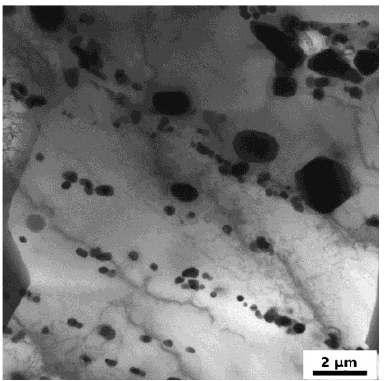
Figure 6. Transmission Electron Microscopy (TEM) micrograph of F0 specimen in the initial state.